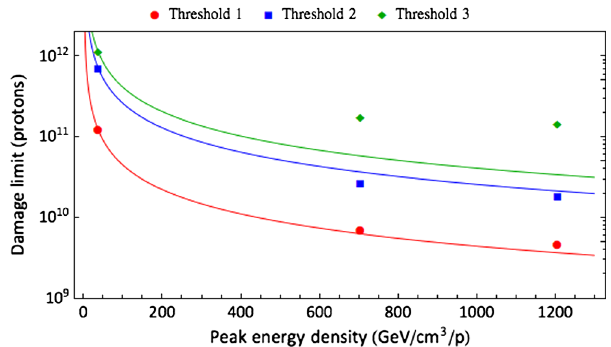
FIG. 22. Correlation between the damage limits of Table IVand the peak energy density per proton for the cases presented in the paper (from left to right: Case 1, Case 3 and Case 2). The lines represent the fit functions y ¼ a=x for each damage threshold.